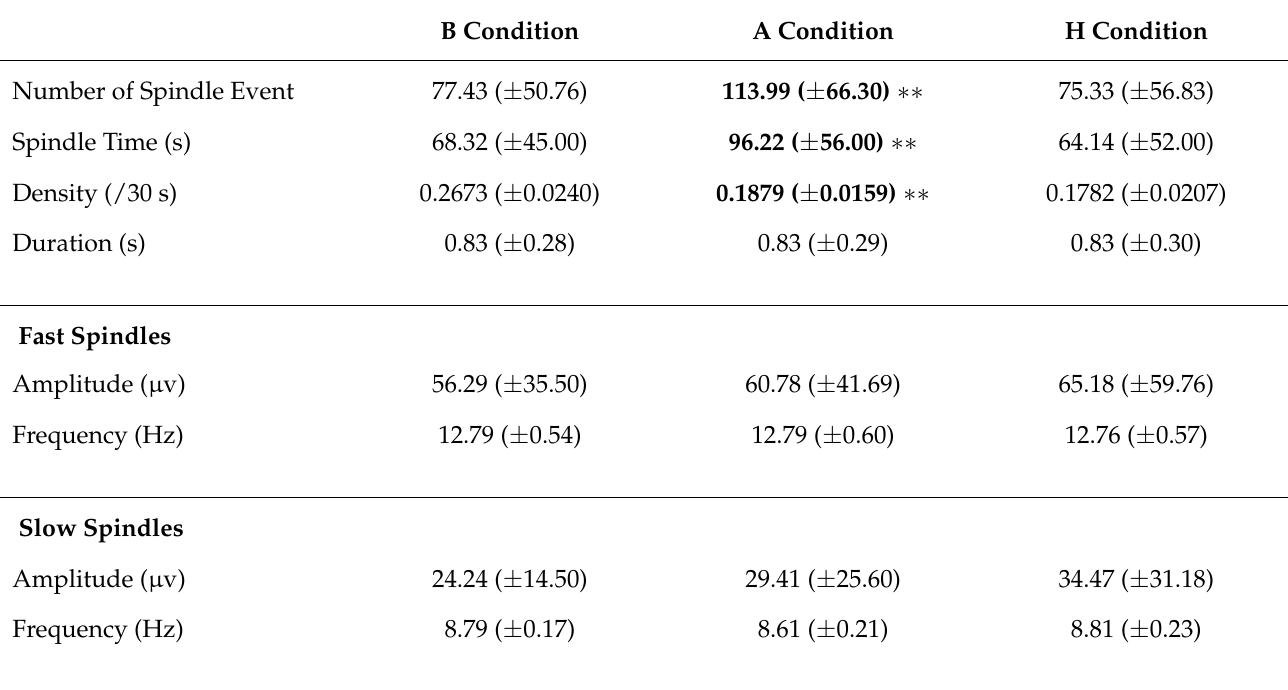
Table 3. Sleep spindle analysis of EEG signals corresponding to each experimental condition during the three-hour